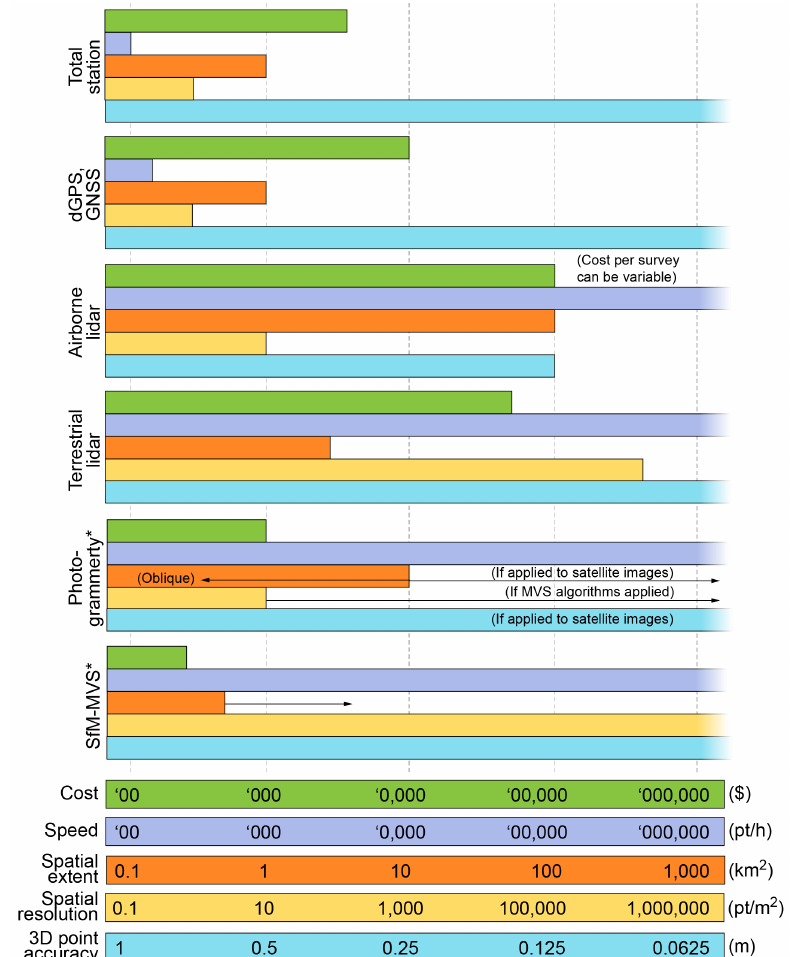
Figure 17. Comparison of digital survey methods with regard to financial cost, maximum possible speed, spatial coverage, resolution, and accuracy; after Figure 2.7 in Carrivick et al. [61]. dGPS—differential Global Positioning System, GNSS—Global Navigation Satellite System, SfM—Structure from